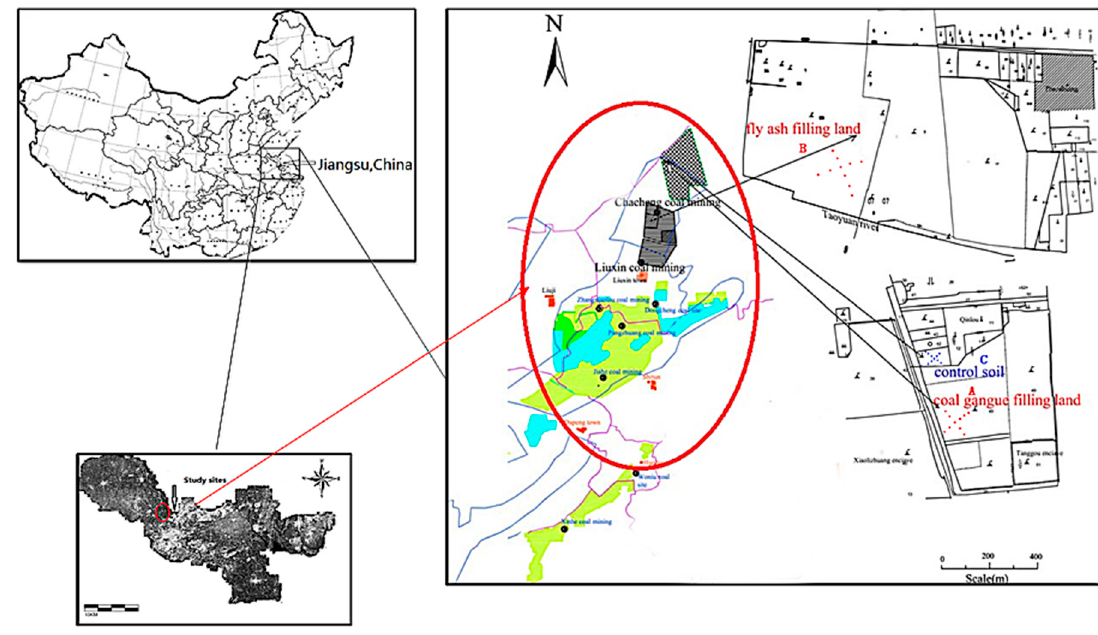
Figure 1. Location and maps of the study area.